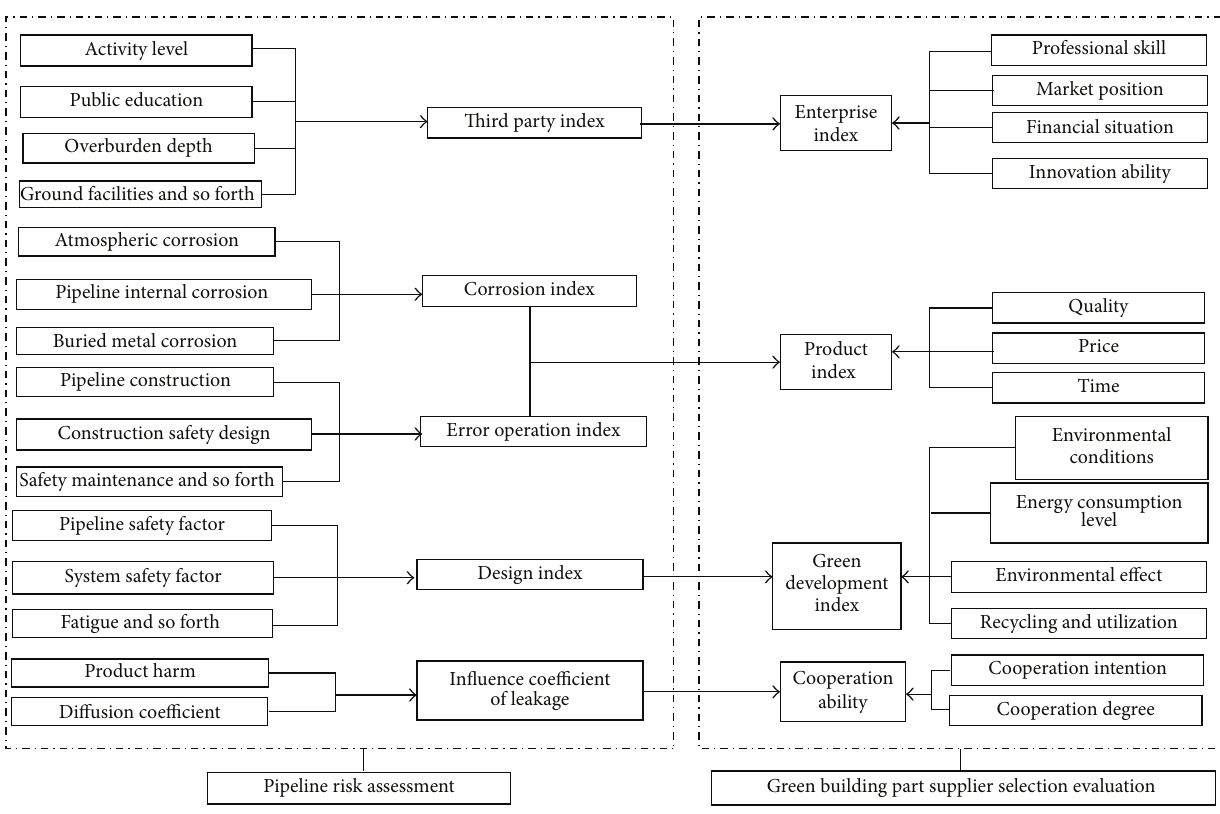
Figure 2: The improved